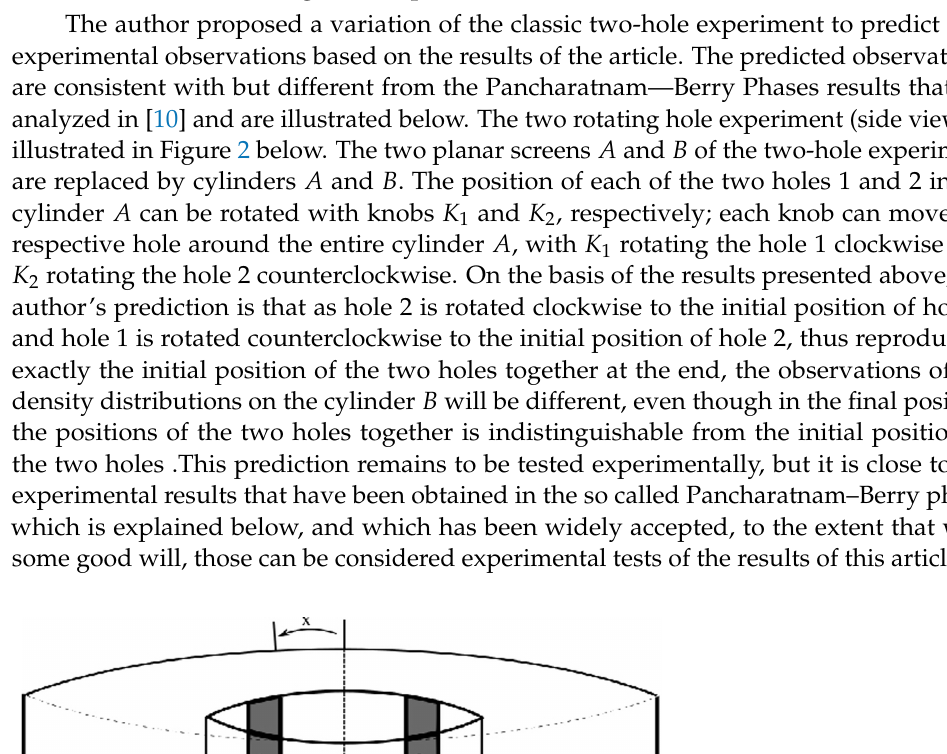
Figure 4: Chichilnisky two rotating hole experiment (top view) angle, and is the classic analog of the Pancharatnam - Berry phase in quantum physics, see e.g. Ong and Lee [15]